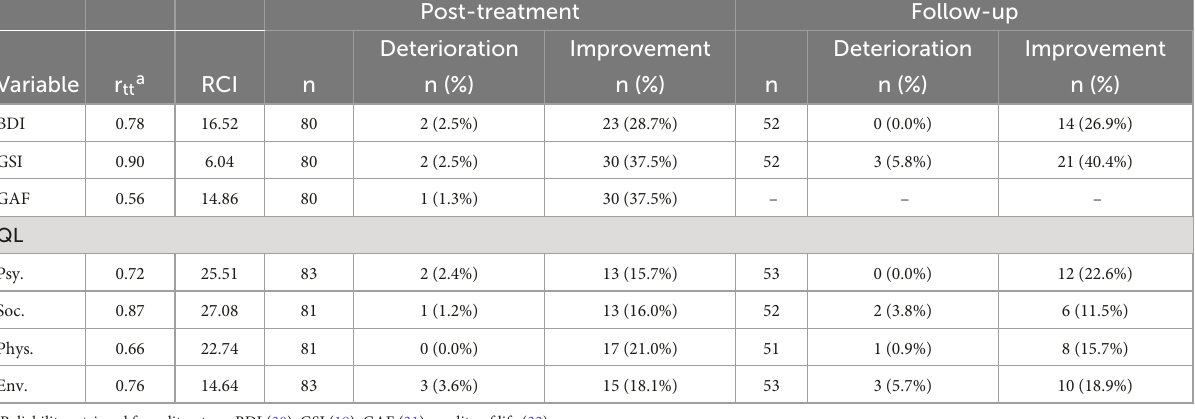
TABLE 5 Reliable change from pre-treatment to post-treatment and follow-up.